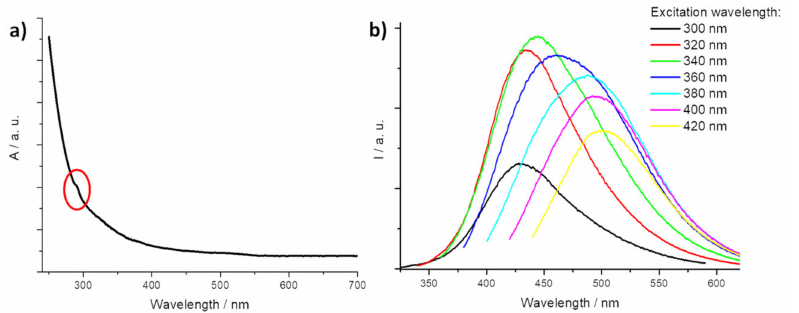
Figure 1. ( a ) UV-Visible spectrum of CNPs. In the red oval, the transition band n– π * is highlighted. ( b ) Fluorescence emission obtained irradiating the CNPs solution with different excitation